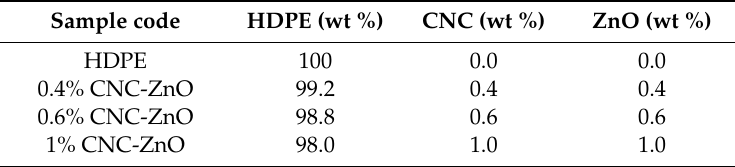
Table 1. Labels and Compositions Details of Examined